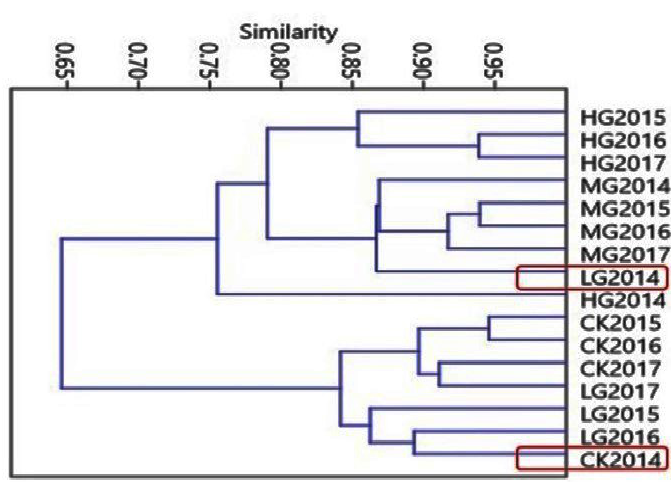
Figure 3. Hierarchical cluster of all grass species having coherent dynamics similarity between grazing intensity in different grazing seasons, the Y right axes the grazing intensity from season 2014 to 2017.